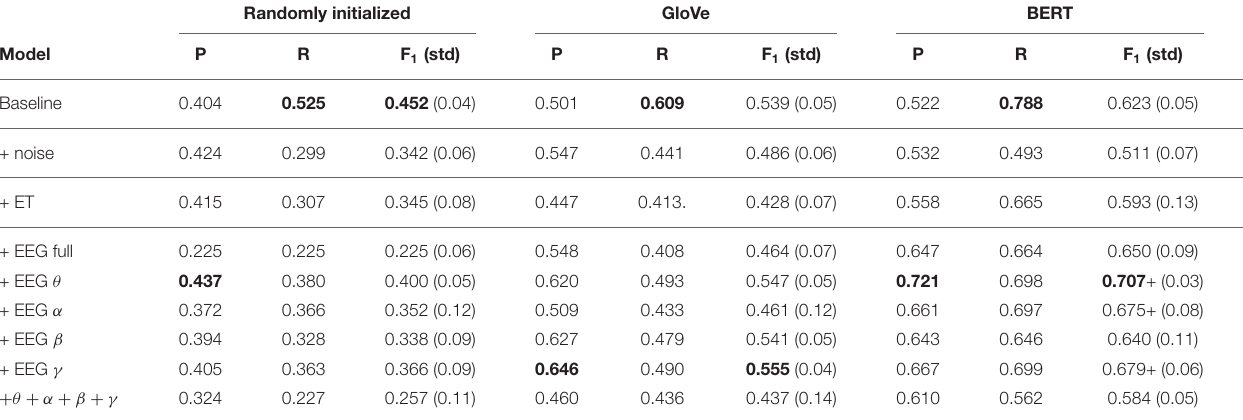
TABLE 9 | Relation detection results of the multi-modal model using the convolutional EEG decoding component . Randomly initialized GloVe